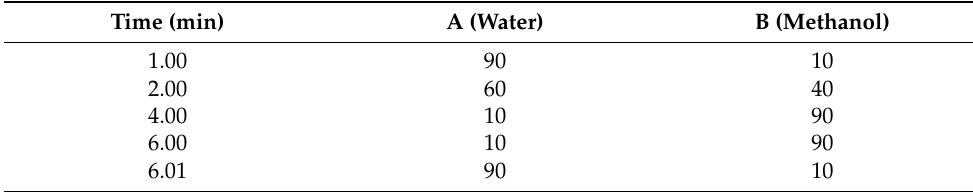
Table 1. Gradient elution